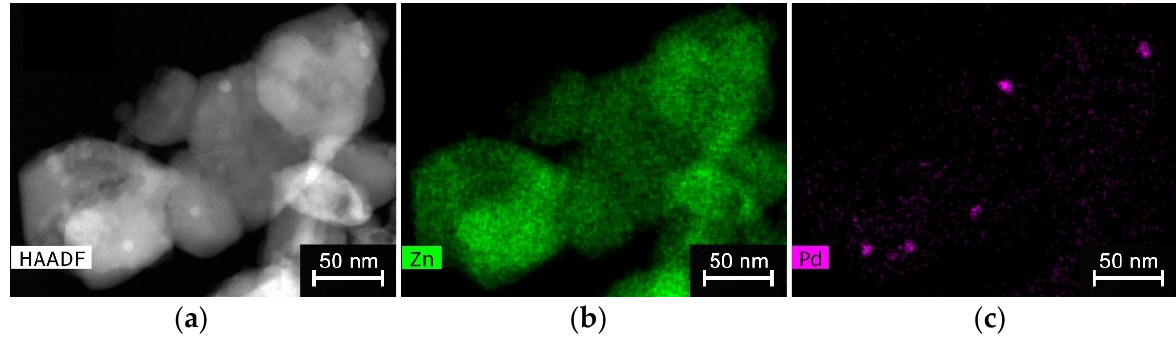
Figure 2. HAADF-STEM image ( a ) and STEM-EDX maps of Zn ( b ) and Pd ( c ) of ZnO/Pd sample.